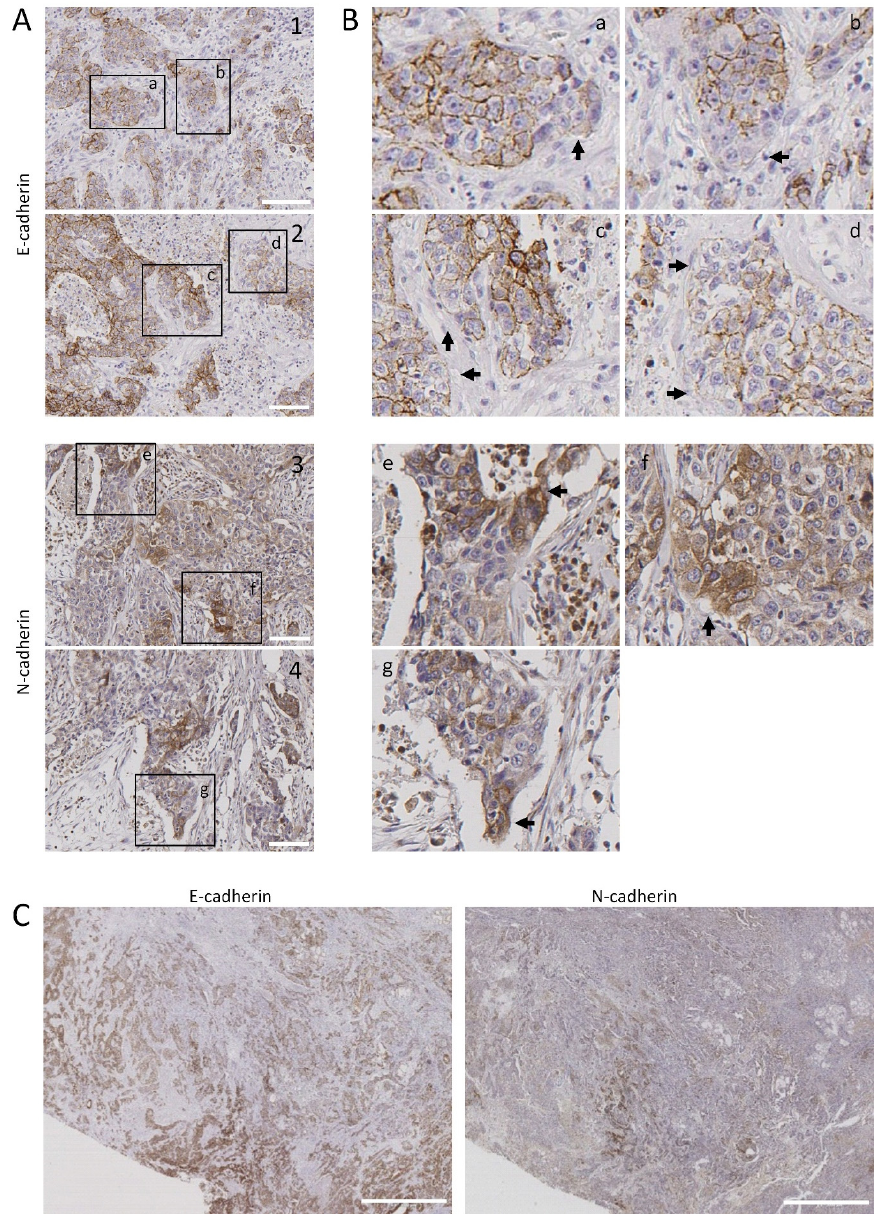
Figure 5. Distribution of E-cadherin and N-cadherin cells in human head and neck SCCs. Representative images from E-cadherin and N-cadherin immunohistochemical stainings of surgically treated head and neck SCC. Panels ( A , B ) show representative tumor sections showing E-cadherin (1, 2) or N-cadherin (3, 4) immunostainings. Higher magnifications of the areas labeled in panel A are shown in panel B. Black arrows point to tumor cells with low E-cadherin (a–d) or high N-cadherin immunostainings (e–g). ( C ) Serial sections of a tumor tissue showing immunostaining of N-cadherin in tumor areas negatively / weakly stained with anti E-cadherin antibody. Scale bars 100 µ m ( A ) and 2000 µ m ( C